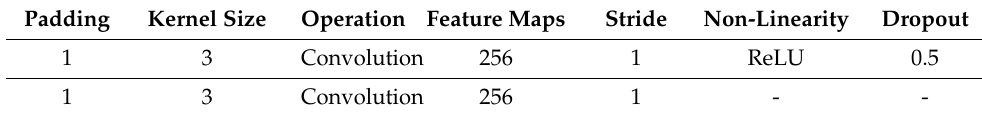
Table 3. Residual block network.